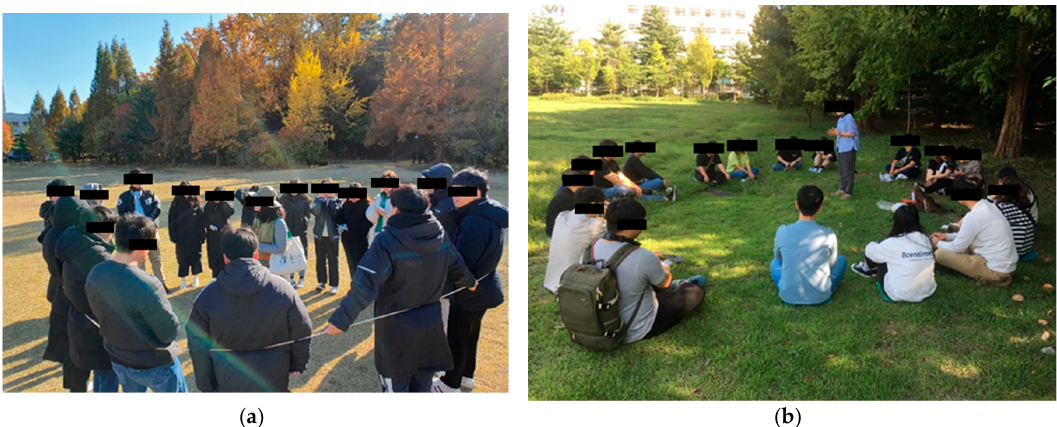
Figure 1. Campus forest therapy program intervention. ( a ) forest folk dance; ( b ) lecture on stress management.